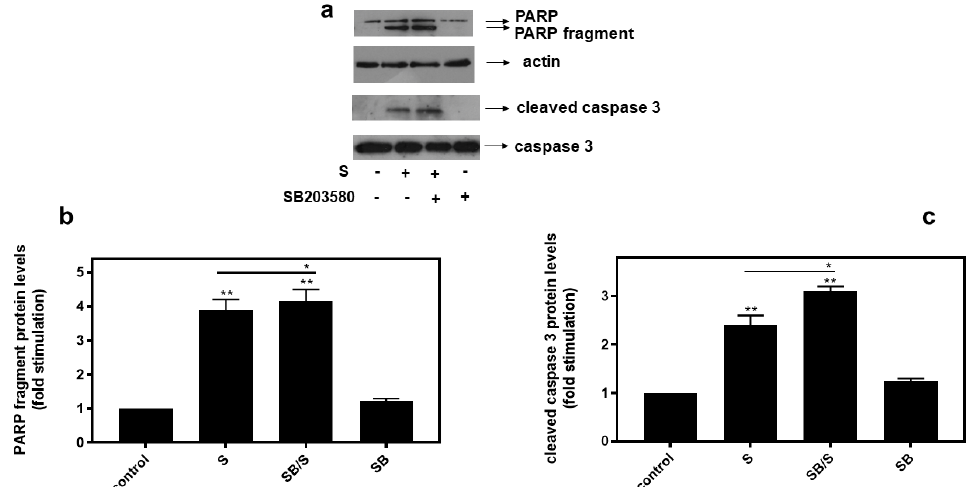
Figure 10. Inhibition of p38-MAPK, by SB203580, enhances hyperosmotic-stress-induced apoptotic markers in H9c2 cardiac cells. H9c2 cells were left untreated (control) or were incubated with SB203580 (SB) alone or with SB203580 followed by exposure to 0.5 M sorbitol in the presence of the inhibitor (SB/S). Cell extracts (40 μ g/lane) were subjected to SDS-PAGE in 12% ( w/v ) polyacrylamide gels and immunoblotted with antibodies against endogenous levels of full-length PARP as well as the large 89 kDa PARP fragment (( a ) upper panel) and of full length (( a ) bottom panel) as well as cleaved caspase 3 (( a ) 3rd panel from top). Equal protein loading was verified by immunoblotting identical samples with a specific anti-actin antibody (( a ) 2nd panel from top). Western blots are representative of at least three independent experiments with overlapping results. Immunoreactive bands were quantified by laser scanning densitometry and plotted ( b , c ). Results are means ± SEM for at least three independent experiments. ** p < 0.01 compared to control values; * p < 0.05 compared to sorbitol-treated cells in the absence of SB203580.